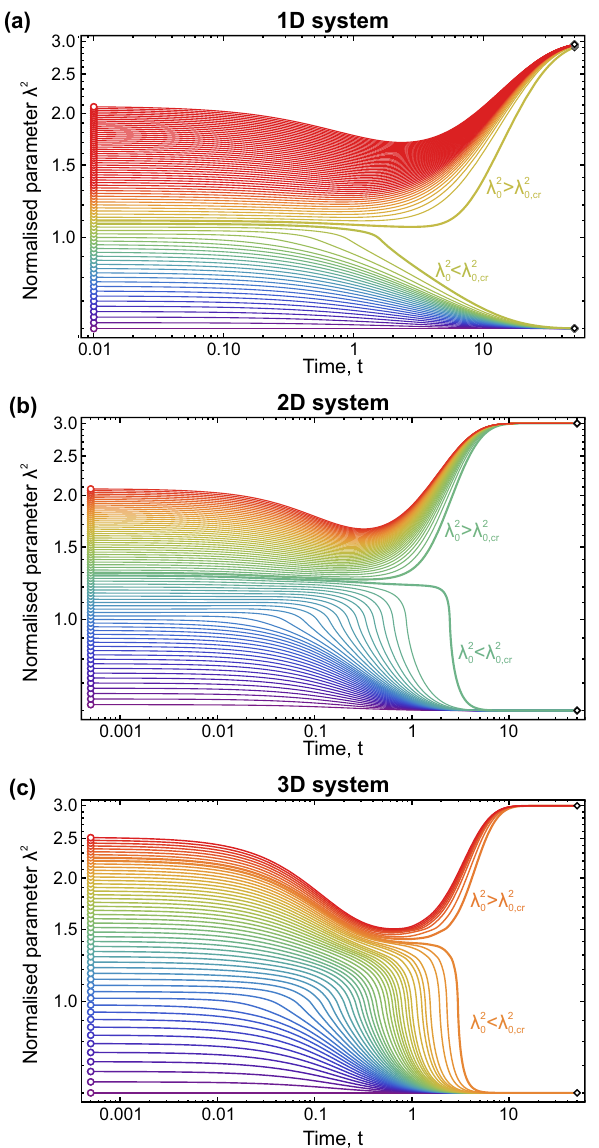
Figure 4. Bifurcation behaviour of different initial fluctuation (10) given with self-consistent model of (cid:31) 2 -evolution: Dependencies of (cid:31) 2 ( t , 0 ) at different initial value (cid:31) 2 ( 0, 0 ) and ( c ) 3D Gaussian nuclei. Bifurcation behaviour is clearly justified with qualitative different (cid:31) 2 ( t , 0 ) -behaviour at small change in the initial state in vicinity of (cid:31) 2 0, cr